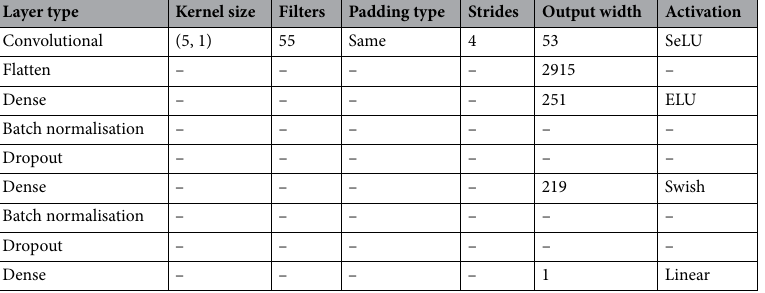
Table 2. Optimal 1D-CNN